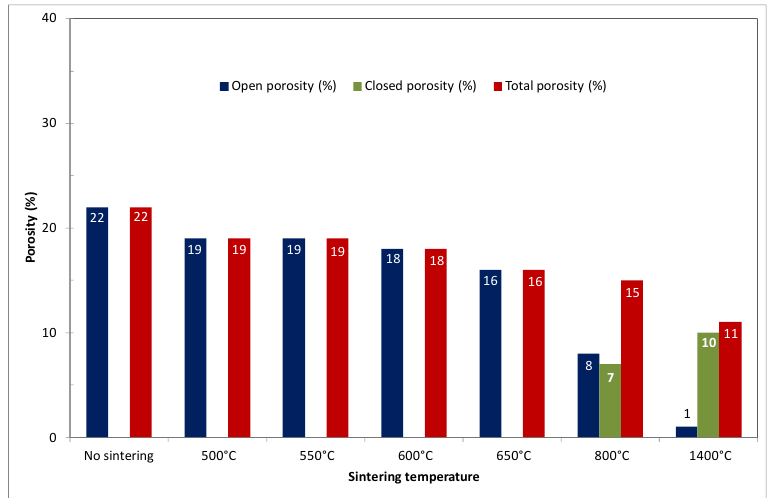
Figure 13. Evolution of the porosity of the Cr pellet with the sintering temperature.